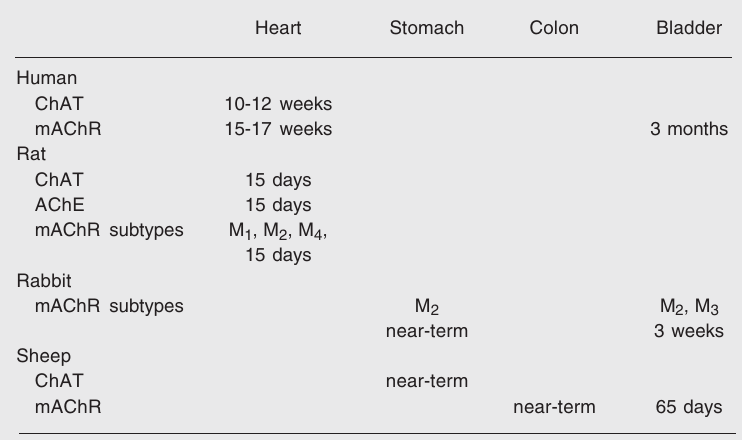
Table 1. Development of peripheral cholinergic elements in the fetal heart and in the fetal urinary and digestive systems during different gestational periods and in different